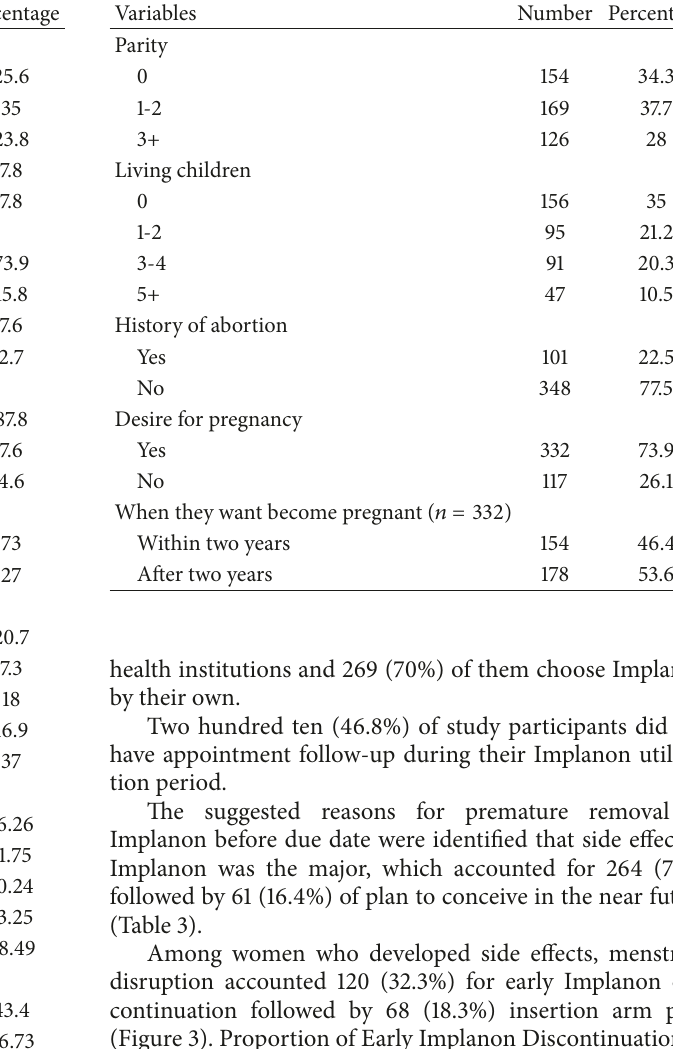
Table 1: Sociodemographic characteristics of Implanon users in Debre Tabor town public health facilities, northwest Ethiopia, August 2016 ( 𝑛 = 449 ).